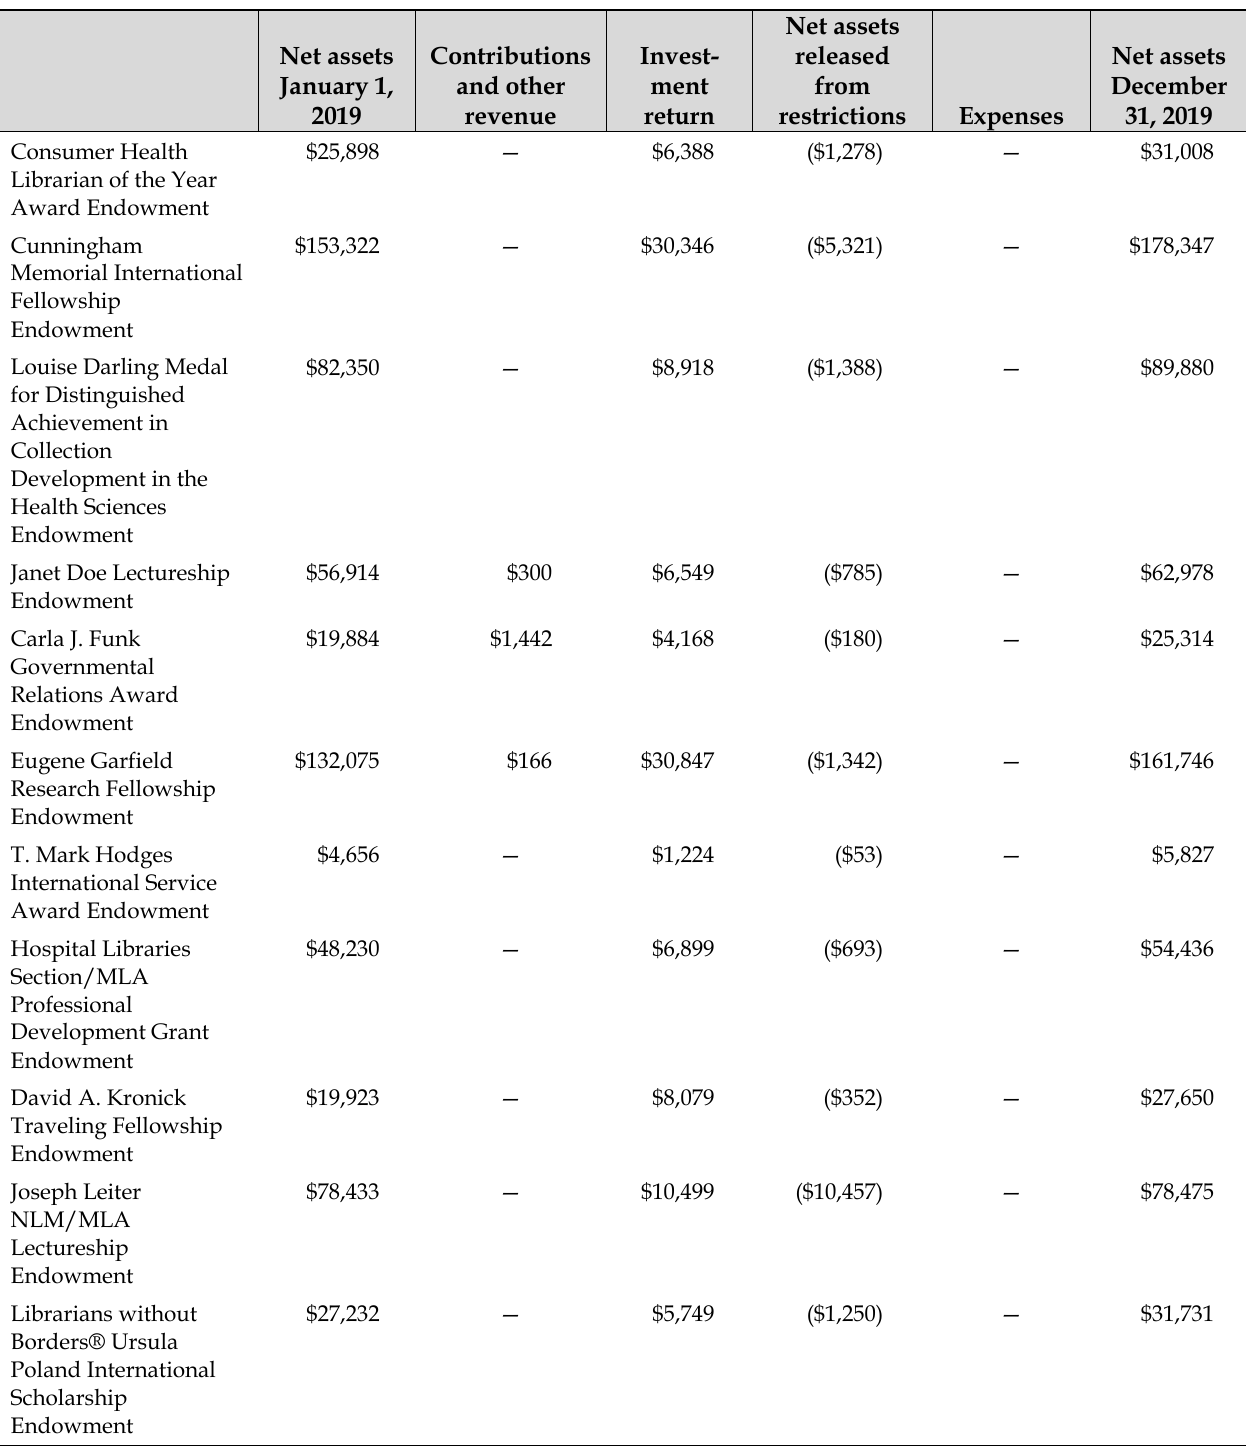
Table 1 Medical Library Association schedule of changes in net assets by fund year ended December 31,